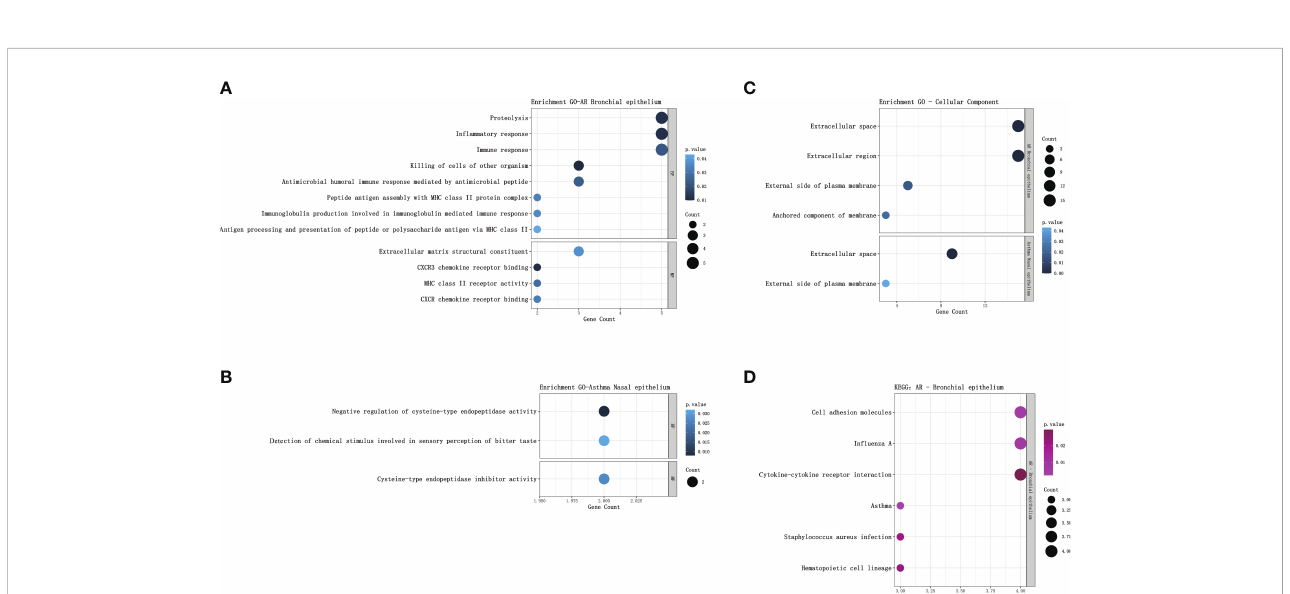
FIGURE 2 GO and KEGG pathway enrichment analysis of DEGs. (A) Bubble chart illustrating the terminology of signi fi cant enrichment of bronchial epithelial DEGs in AR patients in terms of BP and MF. The horizontal axis represents the gene count, and the vertical axis represents the GO terminology. The size of the dots represents the number of enriched genes, and the shades of color represent P -values. (B) Bubble chart showing the terminology of signi fi cant enrichment of nasal epithelial DEGs in asthma patients in terms of BP and MF. (C) Bubble chart showing the terminology of signi fi cant enrichment of DEGs in the nasal epithelium of asthma patients and bronchial epithelium of AR patients in terms of CC. (D) Bubble chart showing enriched signaling pathways associated with bronchial epithelial DEGs in AR patients. GO, gene ontology; KEGG, Kyoto Encyclopedia of Genes and Genomes; DEGs, differentially expressed genes; BP, Biological Processes; MF, Molecular Function; AR, Allergic